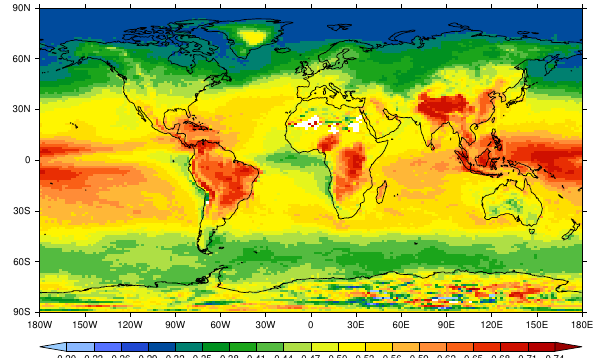
Figure 5. Annual mean in-cloud λ calculated from w ∗ = λσ w from model configuration sigw0.4 at hybrid height of 720m (AWM = 0.51).